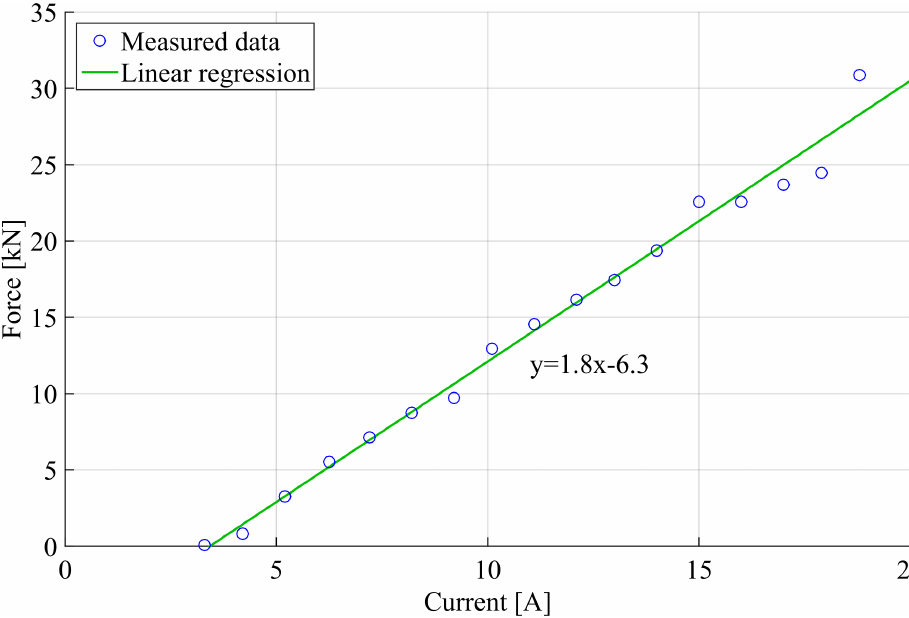
Figure 9. The graph shows the linear correlation between the pulling force applied to the mechanical device and the minimum current required to lift the